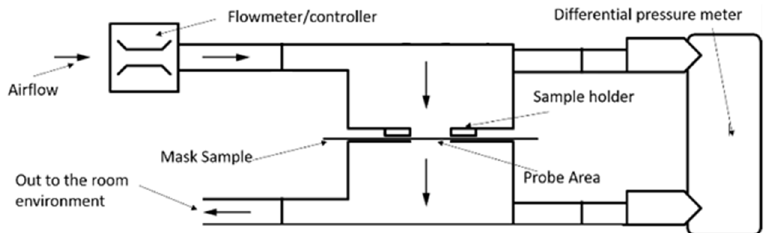
Figure 3. Scheme of the layout of the breathability test, according to the EN 14683 standard [3].